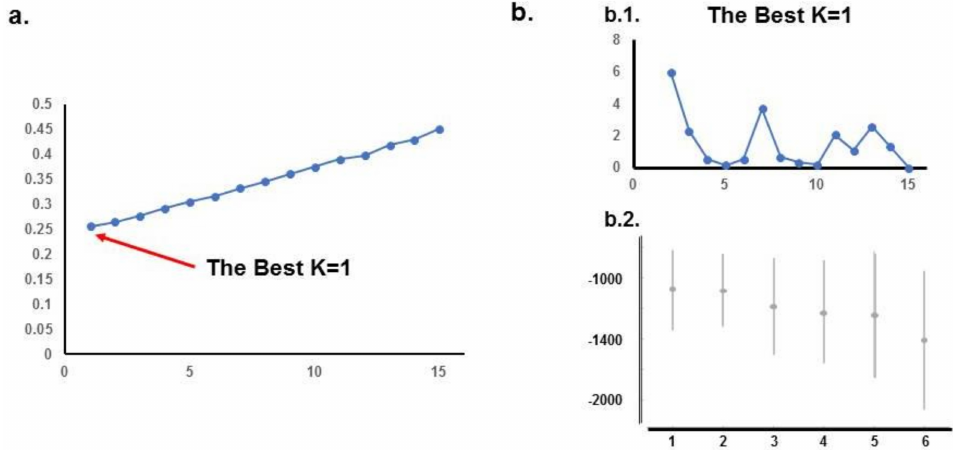
Figure 1. STRUCTURE and ADMIXTURE subpopulations structure analysis of UIHC